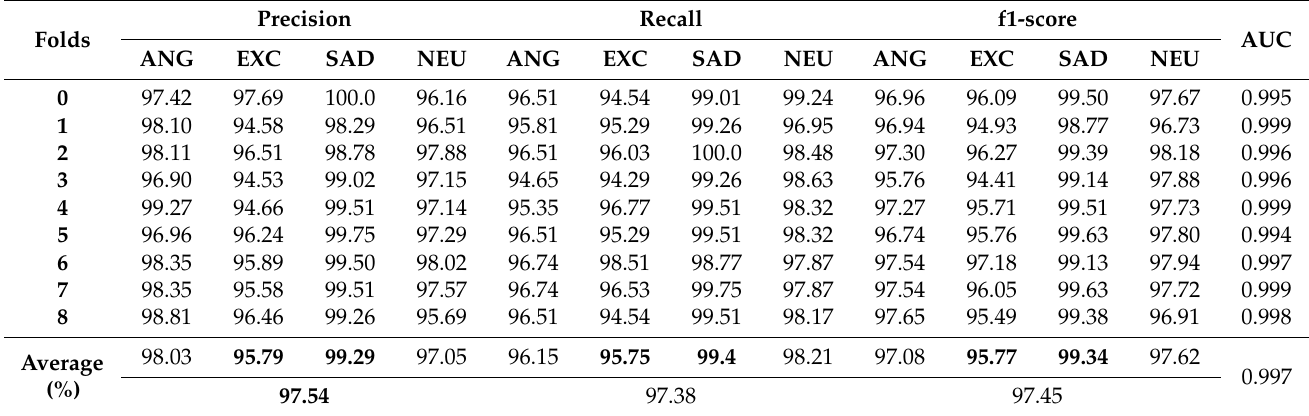
Table 8. Precision, recall, f1-score, and AUC for GRU model with 153 parameters. Precision Folds